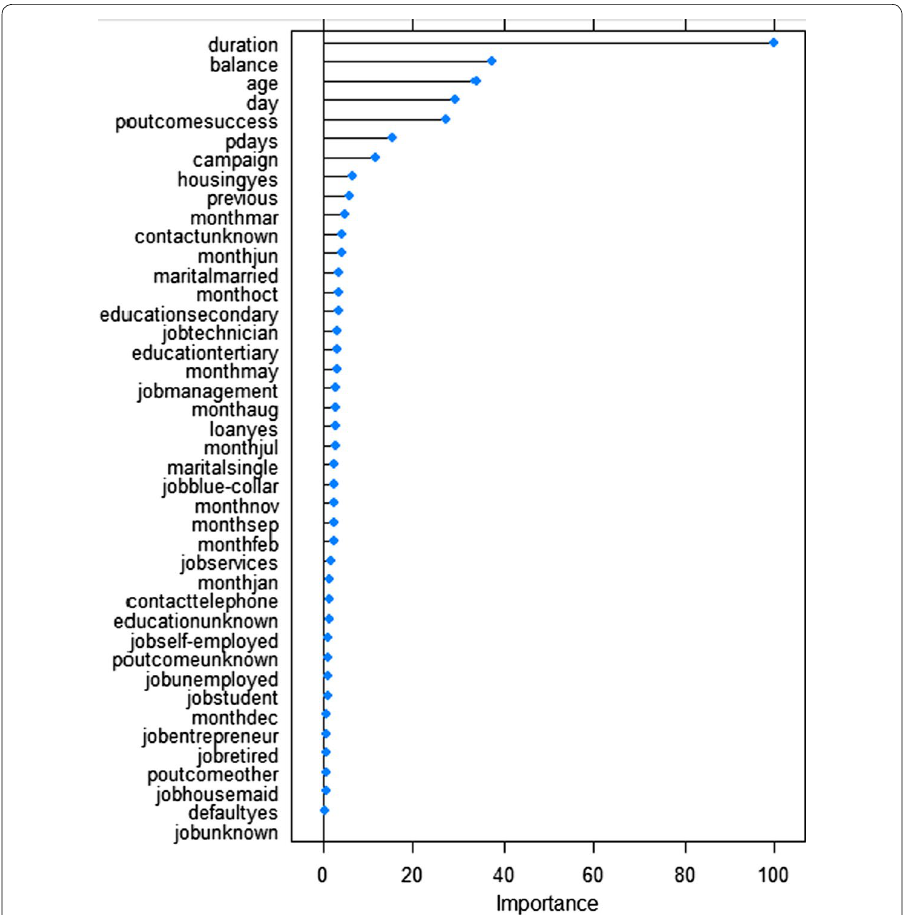
Fig. 2 The important measure for each variable of Bank marketing Dataset using Random